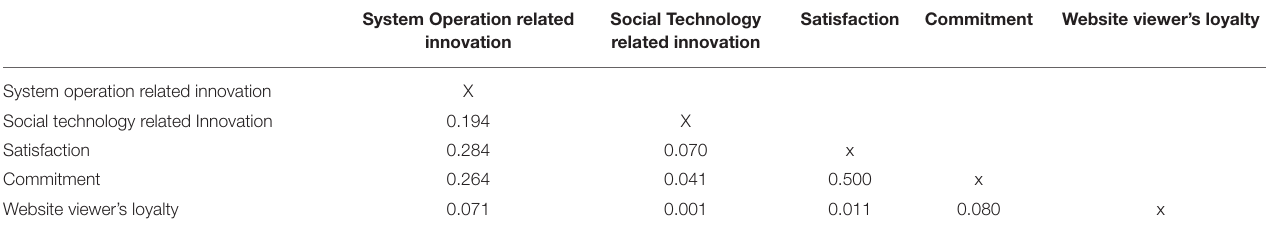
TABLE 4 | HTMT analysis.